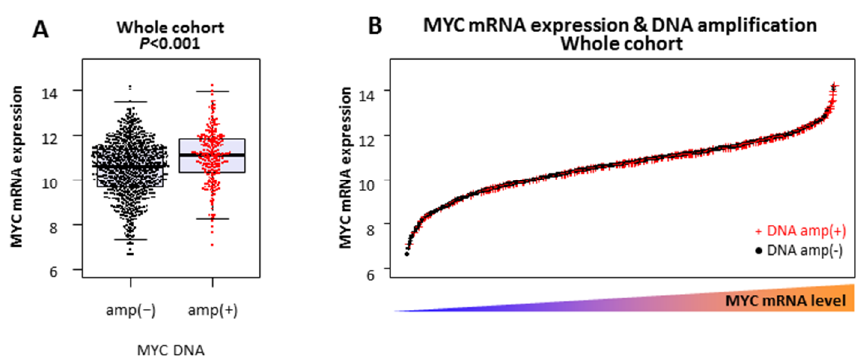
Figure 1. MYC mRNA expression and DNA amplification in The Cancer Genome Atlas (TCGA) whole breast cancer cohort: ( A ) MYC mRNA expression levels of MYC DNA non-amplified (amp(−)) and amplified (amp(+)) tumors, and ( B ) MYC mRNA expression levels of MYC DNA non-amplified (DNA amp(−) in black) and amplified (DNA amp(+) in red) tumors.